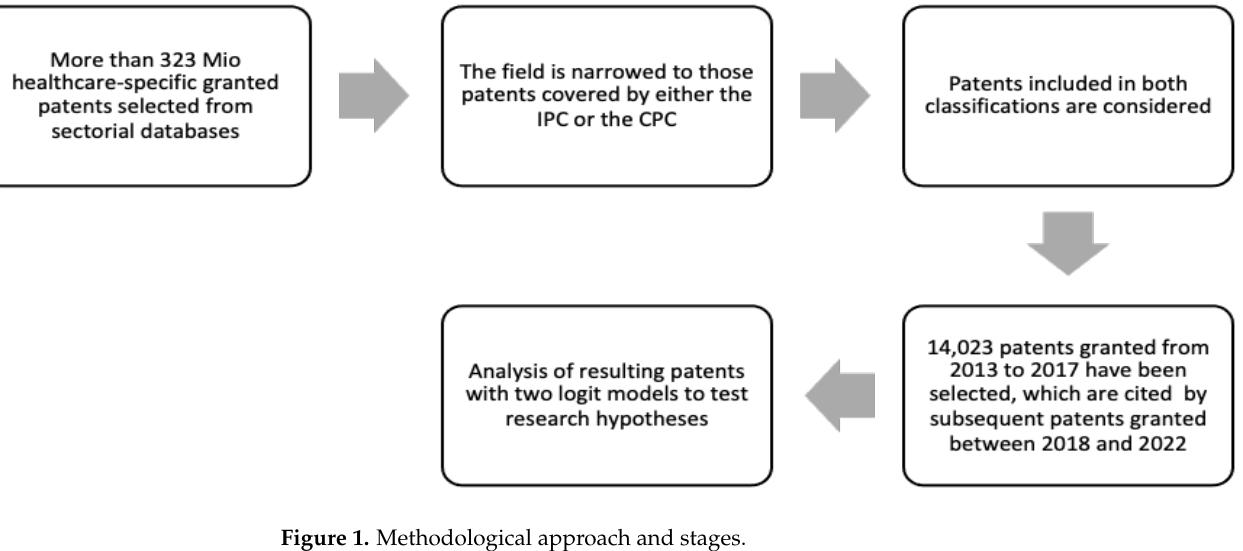
Figure 1. Methodological approach and stages.